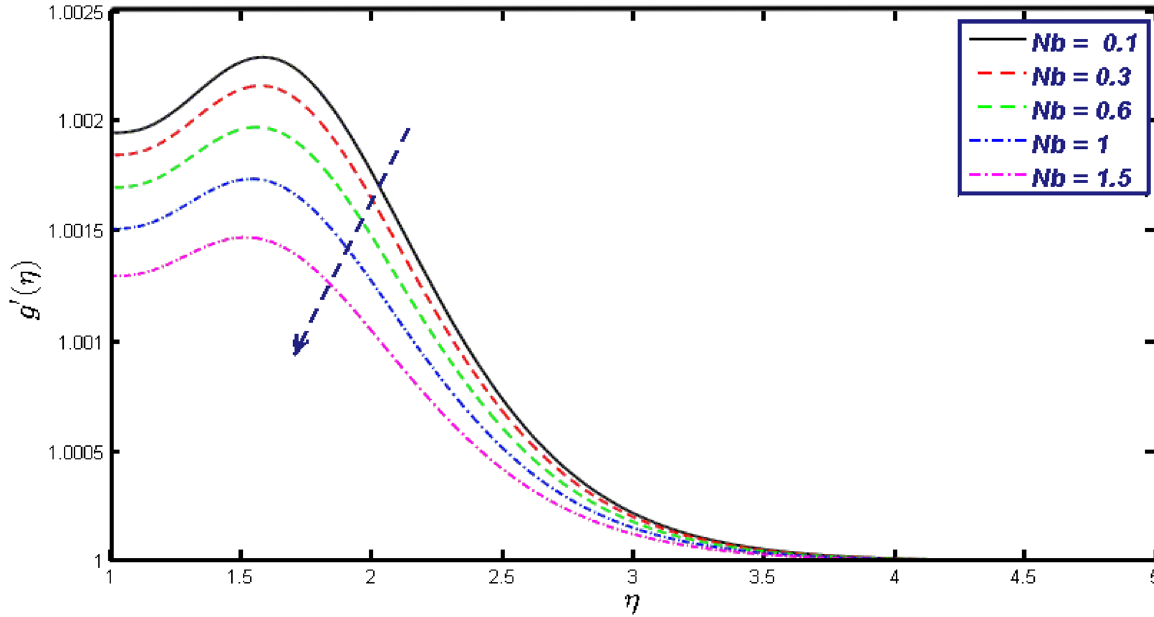
Figure 19. g ′ (η) field for distinct values of Nb .